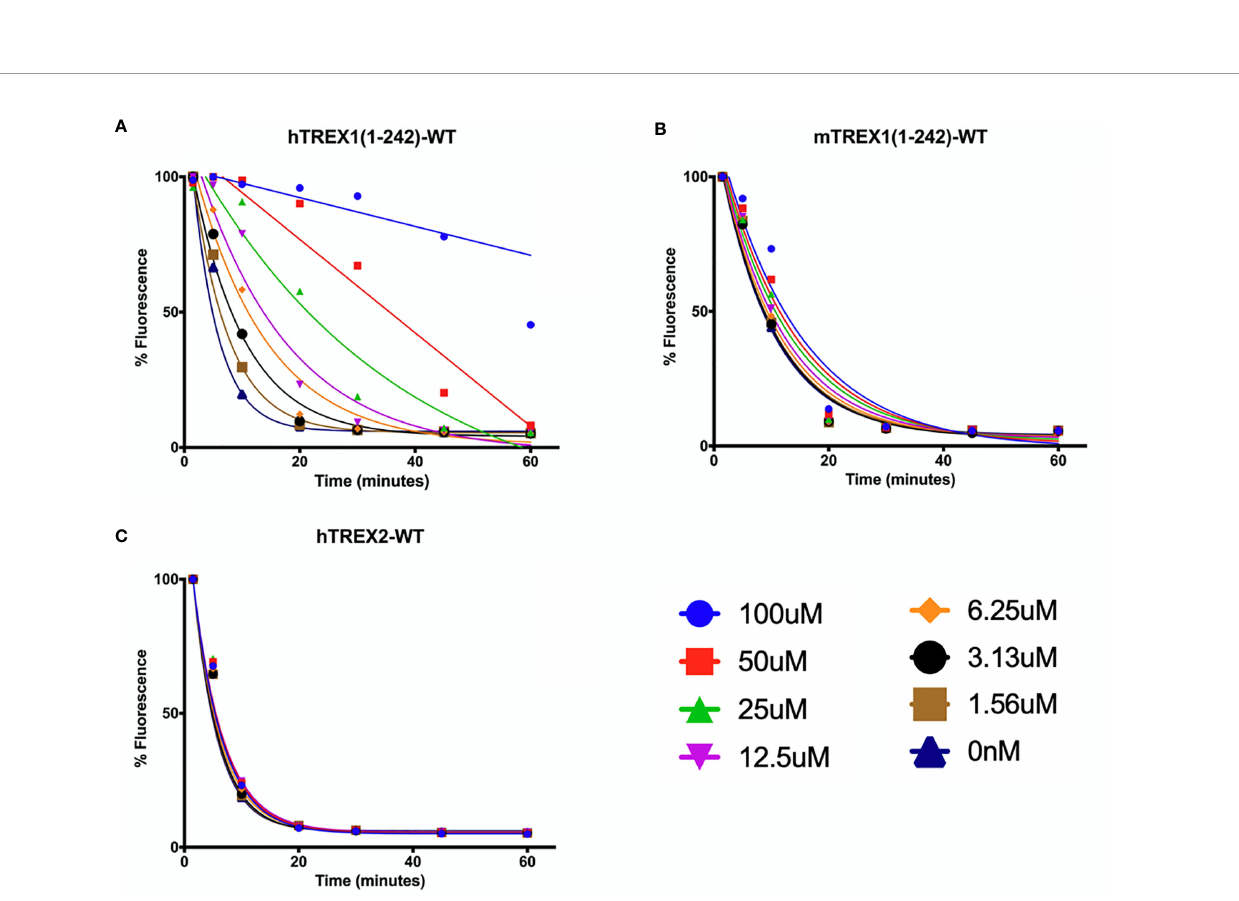
FIGURE 6 | Small Molecule Inhibitor with High Speci fi city for hTREX1. (A – C) Standard time-course reactions were prepared in 150 m L volumes containing vehicle or indicated concentrations of inhibitor, and hTREX1 (A) , mTREX1 (B) , or hTREX2 (C) . Reactions were incubated 1-hr at room temperature, and 20 m L samples of each reaction taken at time-points of 0, 5, 10, 20, 30, 45, & 60 minutes and quenched in 20 m L of 15X SYBR Green. Fluorescence was measured, and fl uorescence vs time plots were normalized to maximal initial fl uorescence and background fl uorescence (see Methods). Plots were fi t with nonlinear regression. Plots were generated in Prism (GraphPad) and combined in PowerPoint.